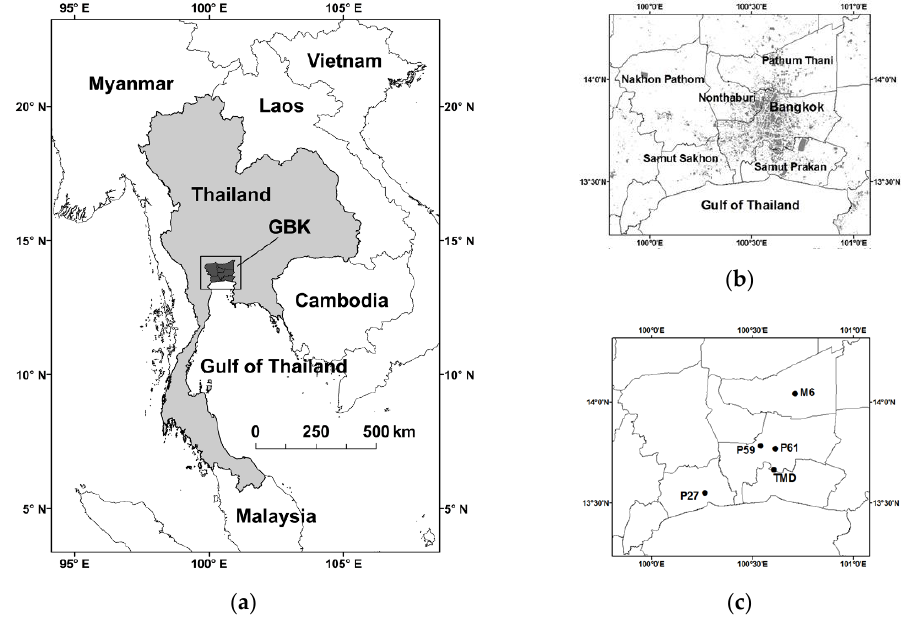
Figure 1. ( a ) Thailand; ( b ) Greater Bangkok and its provinces; ( c ) monitoring stations. In ( b ), the urban